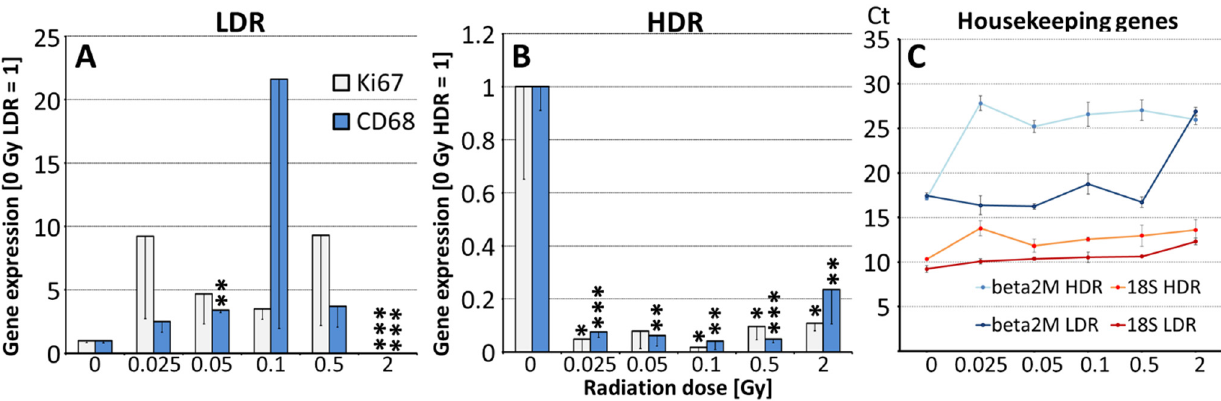
Figure 1. IR dose-dependent expression of Ki67 and CD68 in the spleen of ApoE − / − mice, n = 4. ( A , B ) Relative expression levels of CD68 and Ki67 normalized on 18S rRNA in the spleen, mean-SEM, 3 months after IR at low dose rate (LDR) or high dose rate (HDR) are shown. Significant changes are indicated compared to 0 Gy control (=1) by asterisks (*, p ≤ 0.05; **, p ≤ 0.01; ***, p ≤ 0.001). ( C ) Mean Cycle threshold (Ct) values of house keeping genes, β 2M and 18 S, are presented for all samples, mean ± SEM.